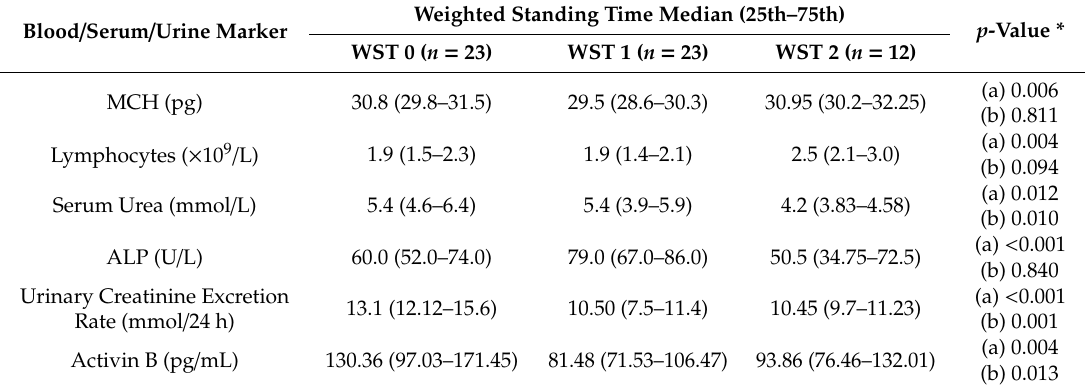
Table 6. Median and 25–75 IQR calculated from a combined class of healthy control and mild ME / CFS cases (WST 0), moderate (WST 1) and severe (WST 2) symptoms correctly predicted by Random Forest Analysis (RFA). ME / CFS was diagnosed via the International Consensus Criteria [12], and WST class calculated from standing test